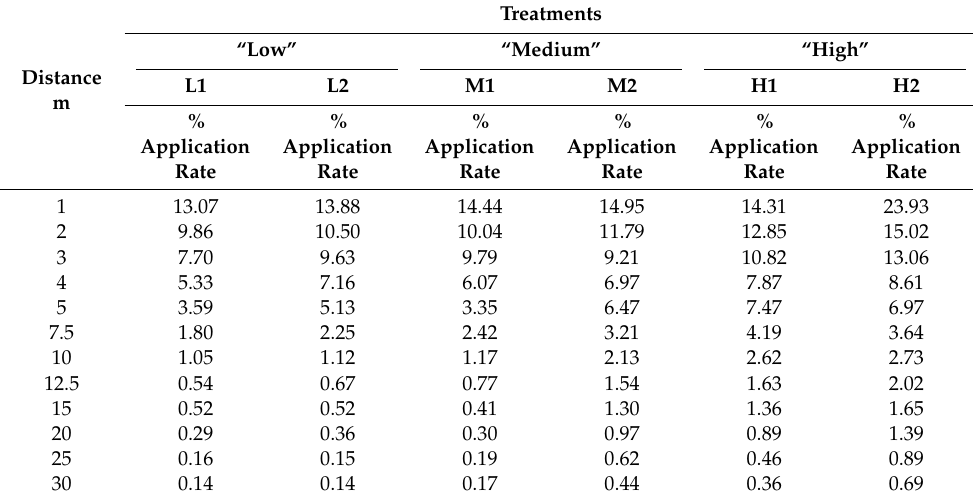
Table 3. Ground deposit of spray